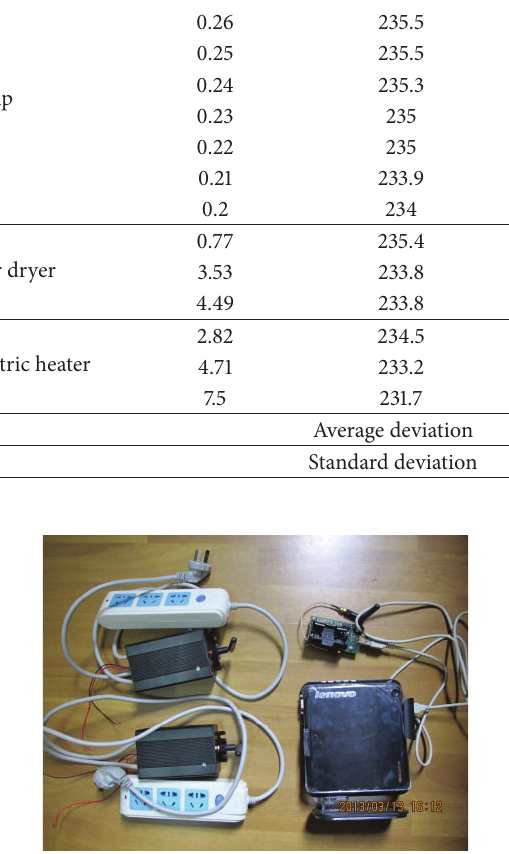
Figure 9: Prototype system.